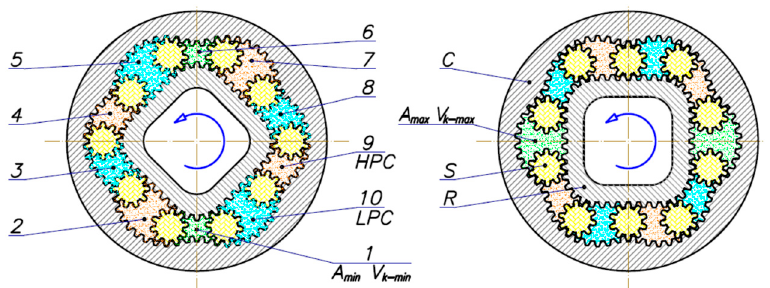
Figure 7. Satellite mechanism of type II [12,23–27,30]: C —curvature, R —rotor, S —satellite, 1÷10— working chambers, HPC —high pressure chambers, LPC —low pressure chambers, V k ‐ min —working chamber with minimum volume (dead chamber) and with minimum area A min , V k ‐ max —working chamber with maximum volume and with maximum area A max .